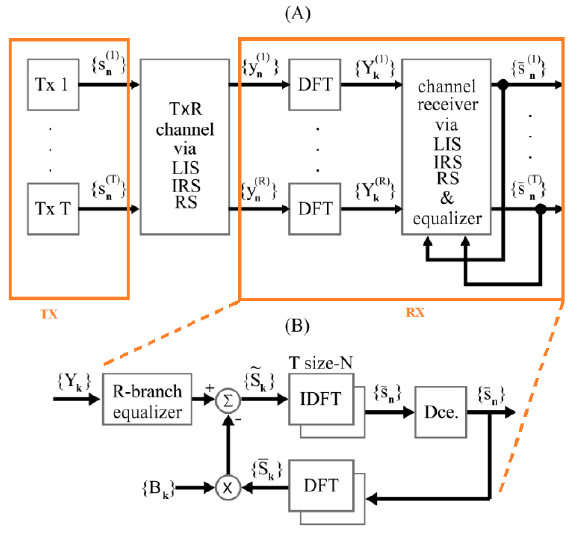
Figure 4. (A)lock diagram of OFDM/SC-FDE iterative FDE receiver. (B) IB-DFE receiver structure . Figure 4. ( A ) lock diagram of OFDM/SC‑FDE iterative FDE receiver. ( B ) IB‑DFE receiver